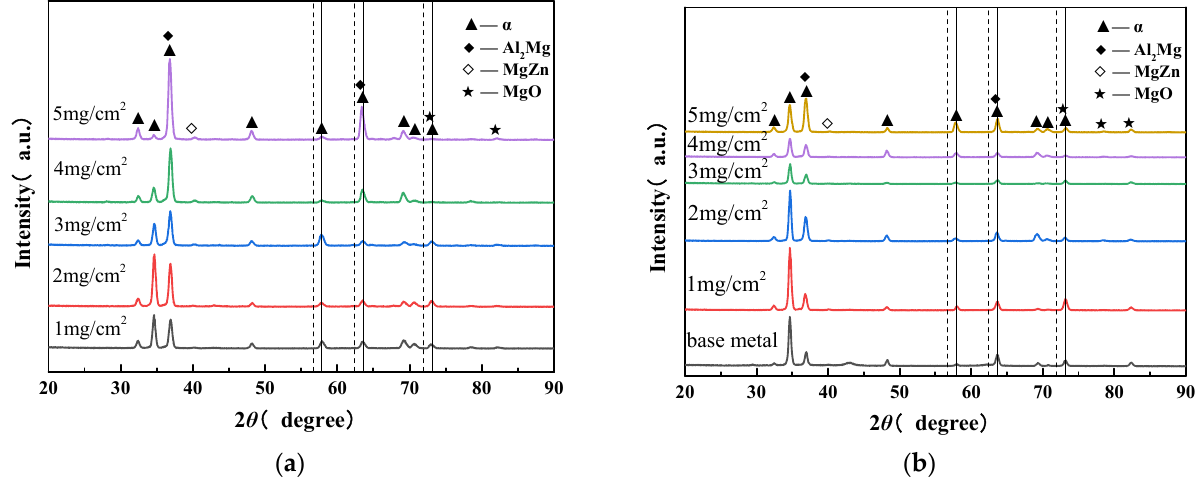
Figure 1. XRD results of welded joints. ( a ) Weld seam; ( b ) base metal and HAZ. With the increase in activated flux amounts, the diffraction peaks of the weld seam still changed to some extent (see Figure 1a). Firstly, with the increase in activated flux amounts, the relative intensities of diffraction peaks changed. When the coating amount of activated flux is less than 2 mg/cm 2 , the strongest diffraction peak was the (002) crystal plane of α -Mg, and as the coating amount of activated flux further increased, the strongest diffraction peak changed to (101) crystal plane of α - Mg. It showed that the microstructure of the weld seam had a certain orientation behavior, this will be specifically analyzed in the following section of EBSD. Secondly, as a second phase, the MgZn phase had a relatively weak diffraction peak when activated flux was relatively small, and the diffraction peak increased significantly with the increase in activated flux. It can be seen that the increase of activated flux was beneficial to the precipitation of MgZn. In addition, the diffraction peak of MgO also fluctuated to some extent under different coating amounts of activated flux. The relative intensity of the diffraction peak was very weak when the activated flux was 2 mg/cm 2 and 4 mg/cm 2 . This indicated that the protective effect of shielding gas was better under the parameter and that the content of MgO in the weld seamwas